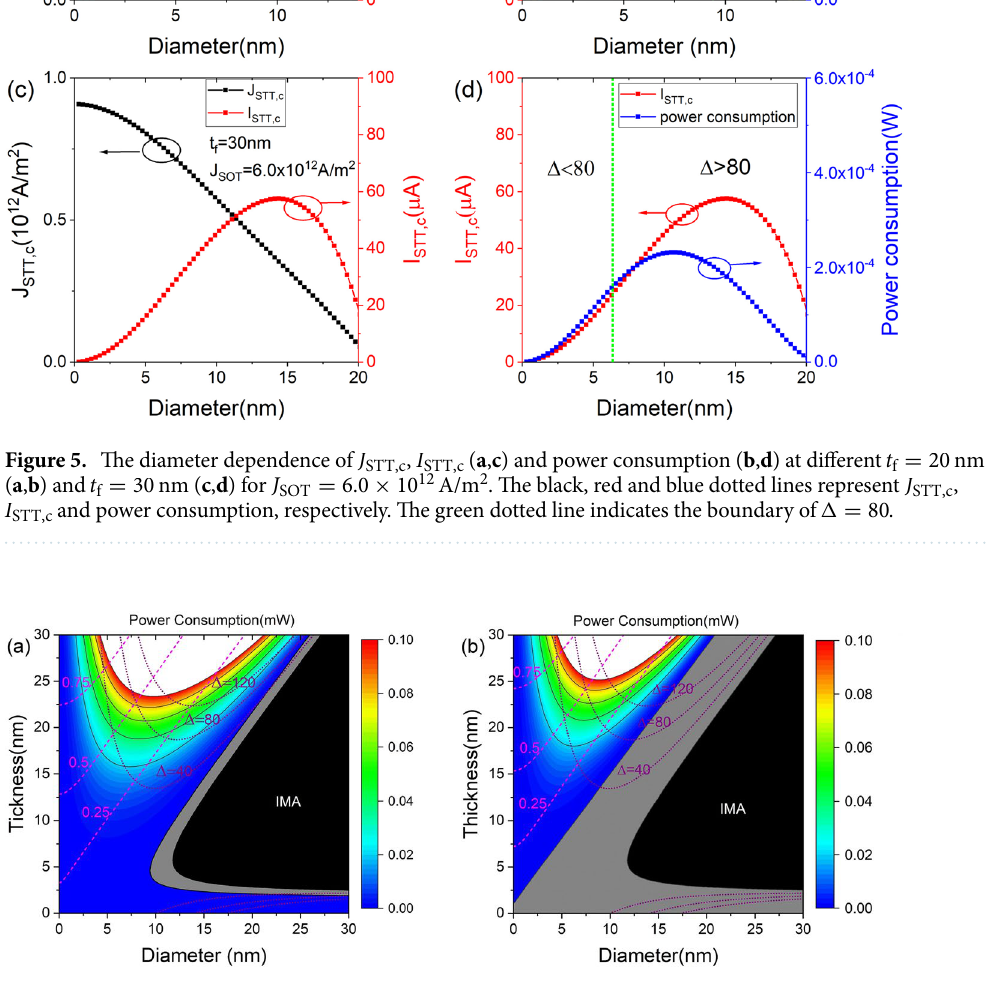
is obtained at the critical switching current. The grey region of Fig. 6a,b is the region where in-plane switching